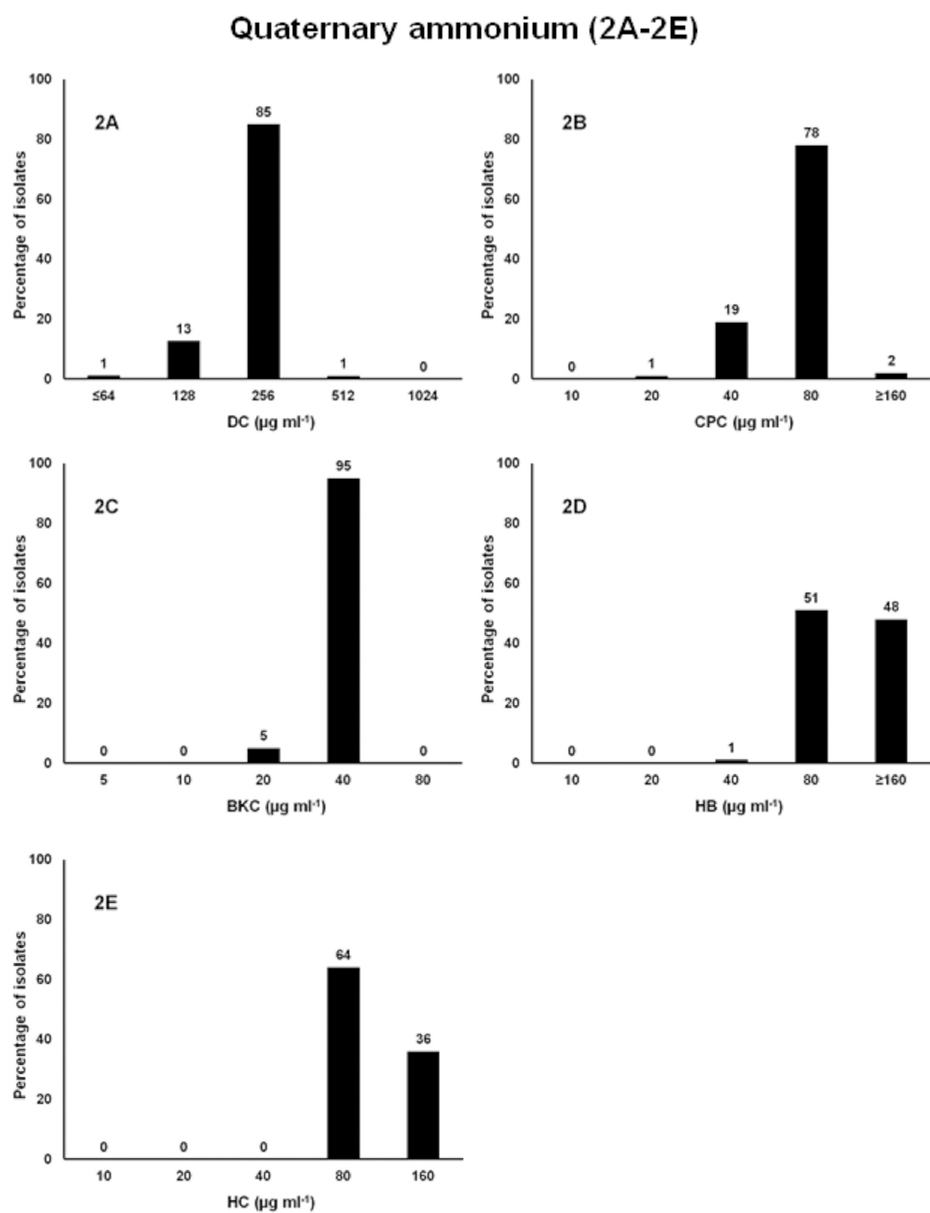
Fig 2. Frequencies of the MICs of the 88 MDR Salmonella isolates to quaternary ammonium compounds (QAC). X-axis is the 2-fold increase of biocide concentration; y-axis is percentage of isolates susceptible at each concentration of the QAC tested. 2A. Dodecyltrimethylammonium chloride, DC; 2B. Cetylpyridinium chloride, CPC; 2C. Benzalkonium chloride, BKC; 2D. Hexadecyltrimethylammonium bromide, HB; and